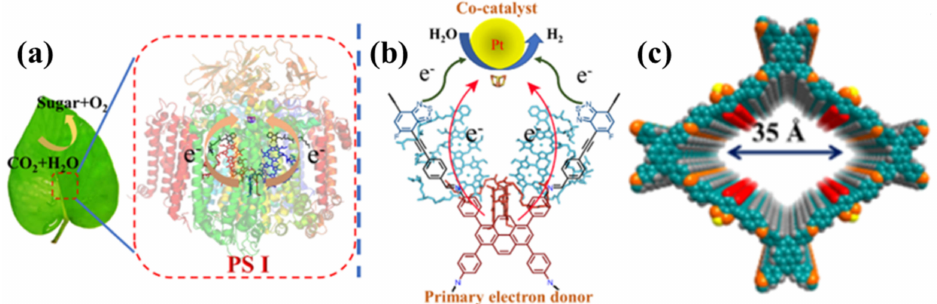
Figure 5. ( a ) The relationship of donor − acceptor moieties in PS I. ( b ) Mechanism of hydrogen production from photocatalytic water splitting for NKCOFs-108 (via analogy with PS I). ( c ) Structural models for NKCOFs with perfectly eclipsed AA stacking shown parallel to the pore channel along the crystallographic c axis. Reproduced with permission from Ref. [44]. Copyright: American Chemical Society,